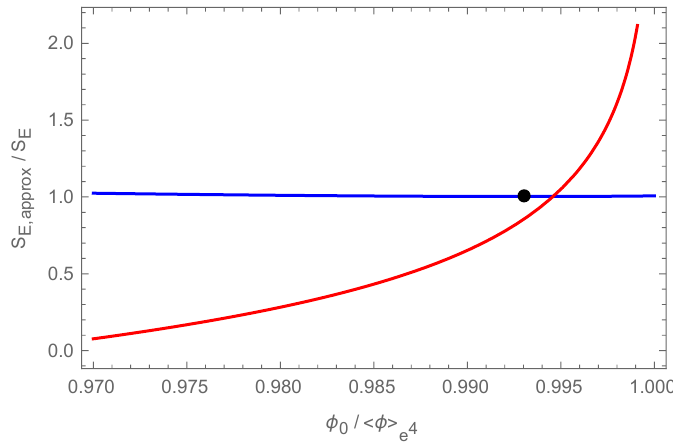
S K (blue) and S E = − S V (red). The point of 2